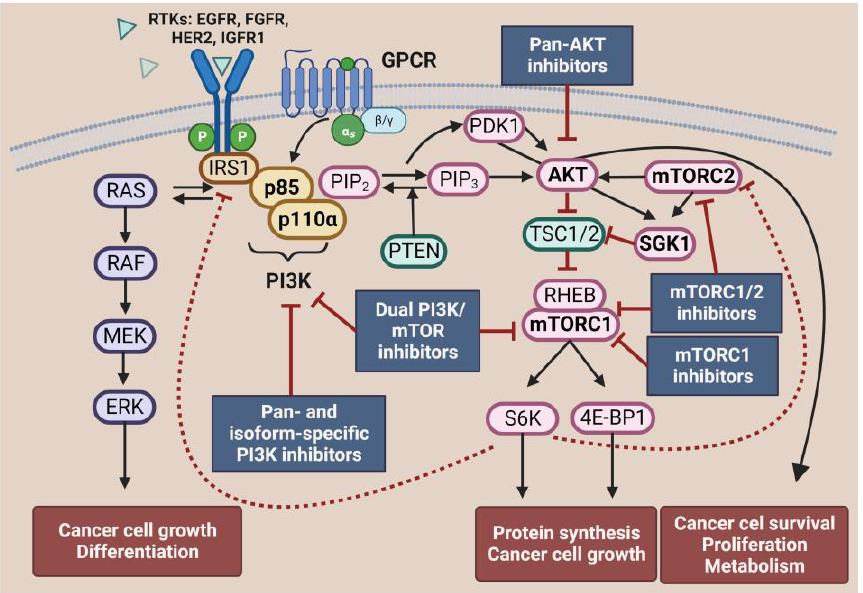
Figure 1. Schematic representation of the PI3K/AKT/mTOR pathway and its targetable regulators. RTK activation stimulates PI3K to convert PIP2 to PIP3, which recruits PDK1, AKT and mTORC2 to the plasma membrane. Both PDK1 and mTORC2 activate AKT, which activates mTORC1. A negative feedback loop is induced by mTORC1 at IRS1. The negative regulator PTEN converts PIP3 back to PIP2. GPCR, G protein-coupled receptor; RTK, receptor tyrosine kinase; IRS1, insulin receptor substrate 1; PDK1, phosphoinositide-dependent kinase 1; PIP2, phosphatidylinositol 4,5-bisphosphate; PIP3, phosphatidylinositol 3,4,5-trisphosphate.